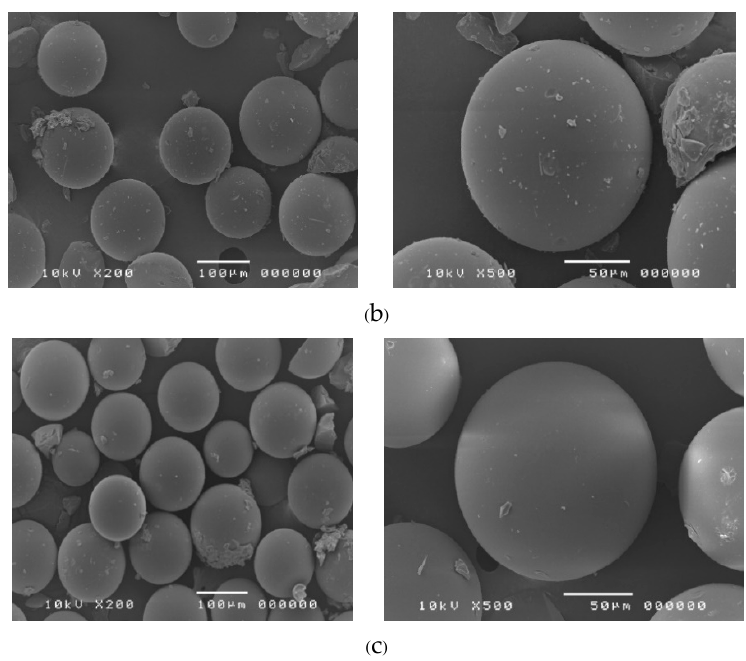
Figure 4. Scanning electron microscopy of Dowex resin ( a ) , NZD-resinate complex at ratios of 1 : 3 ( b ) and 1 : 5 ( c ) at magnification of 200× ( left ) and 500× ( right ).